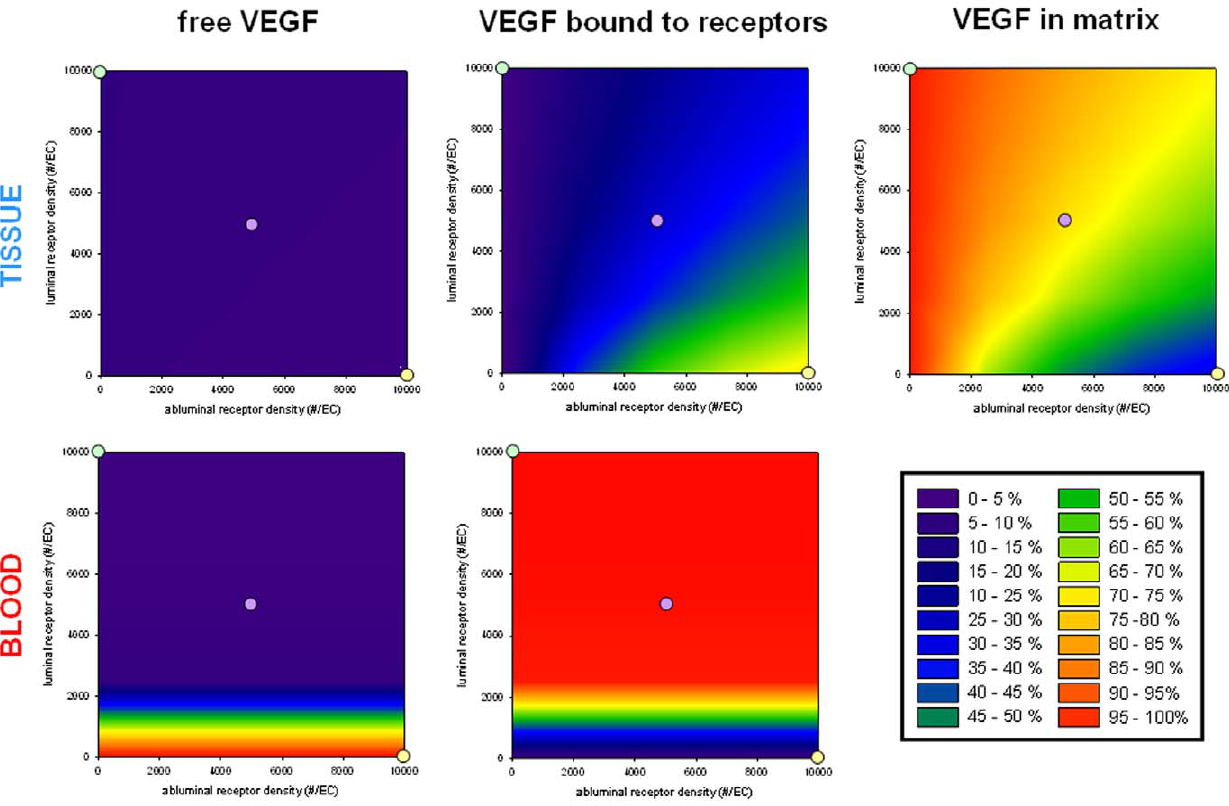
Figure 8. VEGF distributions in the tissue and in the blood. The setup is similar to that in Figure 4. Top row: VEGF distribution in the tissue; bottom row: VEGF distribution in the blood. The first column corresponds to the percentage of free VEGF; the second column the percentage of VEGF bound to the receptors; the third column the percentage of VEGF bound to the extracellular matrix and basement membranes.